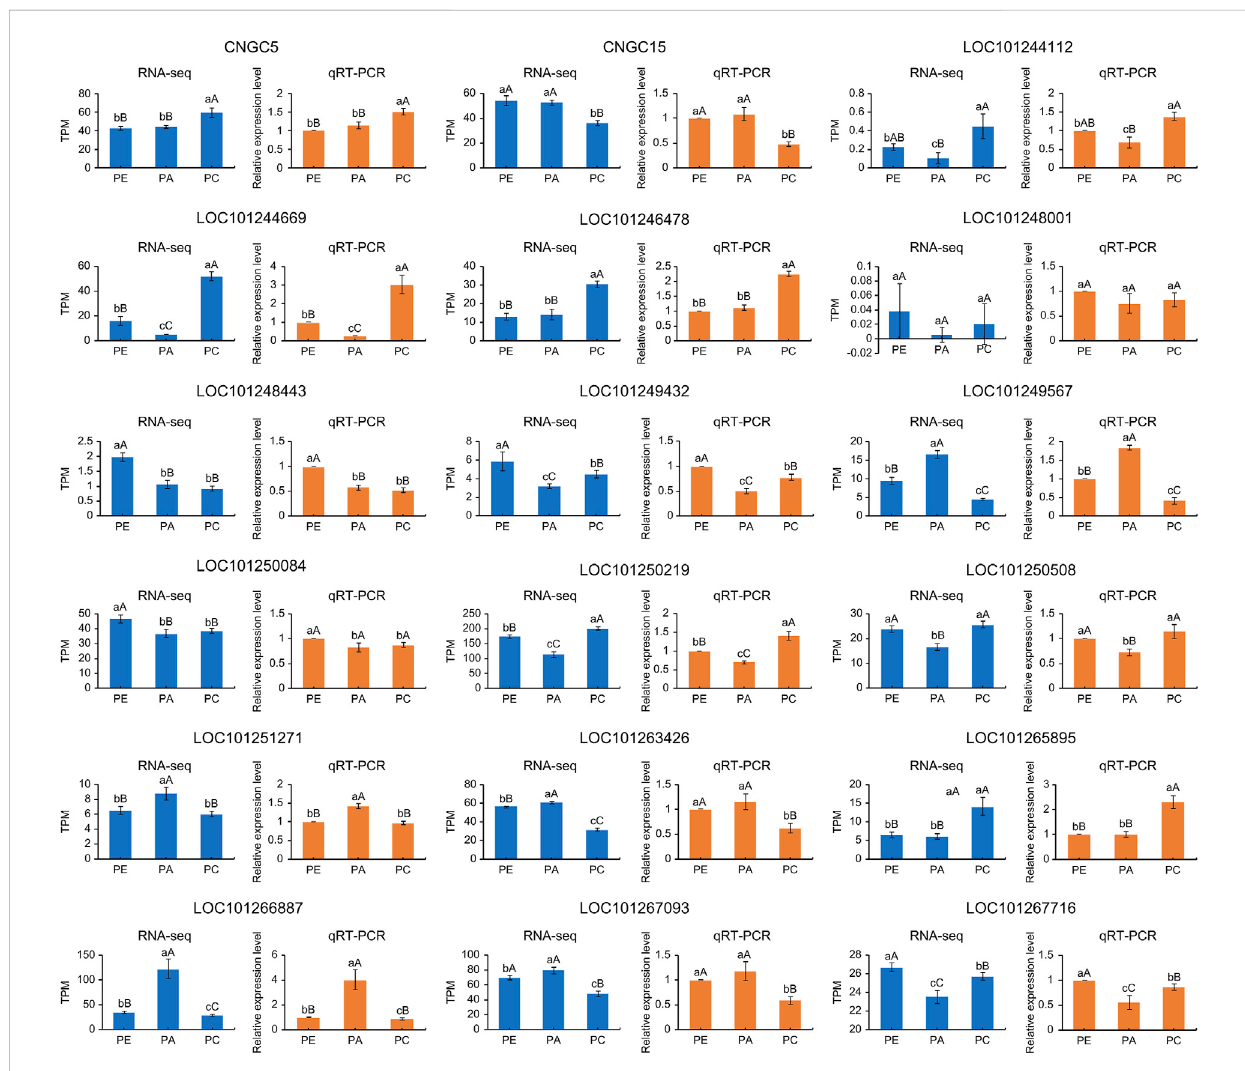
FIGURE 9 TPMvaluesandrelativeexpressionlevelsoftencyclicnucleotide-gatedionchannelgenesexpressedinPE,PA,andPC.Theorangebargraphsshow geneexpressionmeasuredbyqRT-PCRandthebluebargraphsshowgeneexpressionmeasuredbyRNA-seqinTPMunit.WT:wild-typesamples;PE:the drought stress samples; PA: the samples sprayed with exogenous abscisic acid under drought stress; PC: the samples sprayed with exogenous calcium under drought stress. Data are means (±SD) of three biological replicates. Different lowercase and uppercase letters indicate signi fi cant differences at p < 0.05 and p < 0.01,